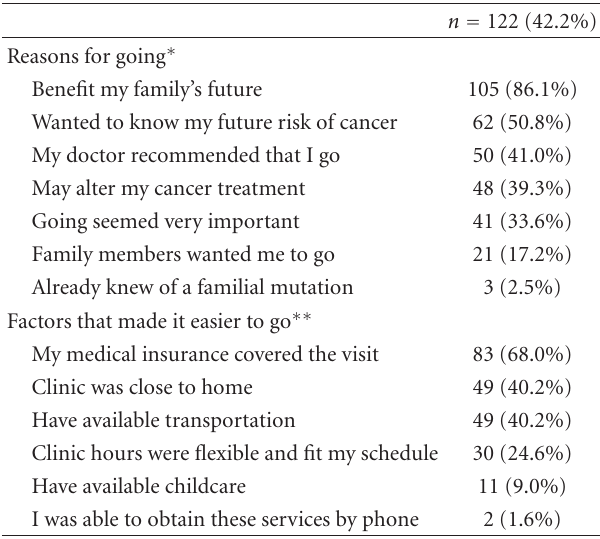
Table 3: Reasons for going to genetic counseling and risk assess- ment and factors that made it